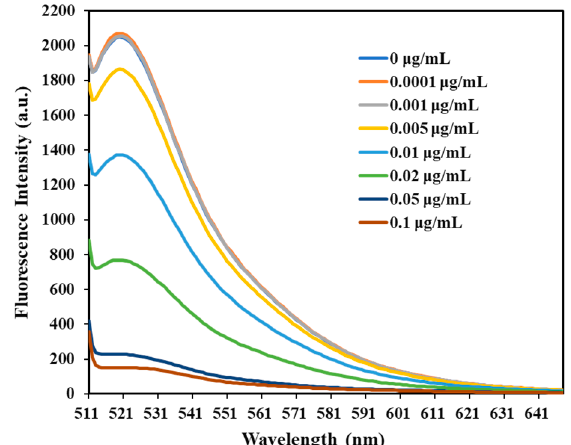
Figure 4. Effect of pGO25000 concentrations from 0 to 0.1 µ g/mL on fluorescence quenching of FAM– ssDNA.